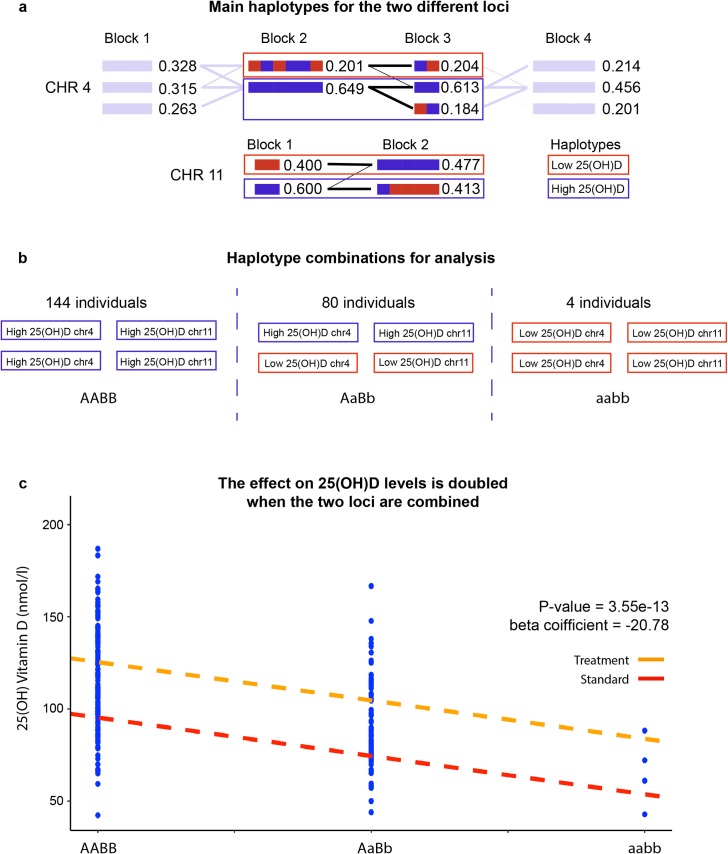
Identifying the main haplotypes for each of the two significant loci.a) Using the more confident non-imputed data haplotypes were constructed using Haploview for the regions surrounding both lead SNPs at each locus. The main haplotype associated with low 25(OH)D were identified for each locus. b) To measure the combinatory effect of ‘low 25(OH)D haplotypes’ all individuals matching a haplotype combination of AABB, AaBb or aabb were grouped together (n = 228). c) 25(OH)D measurement at 24 months for each individual in each haplotype group. When combining the haplotypes, the effect on the 25(OH)D concentrations is approximately doubled (beta = -20.78) compared to viewing each locus alone.